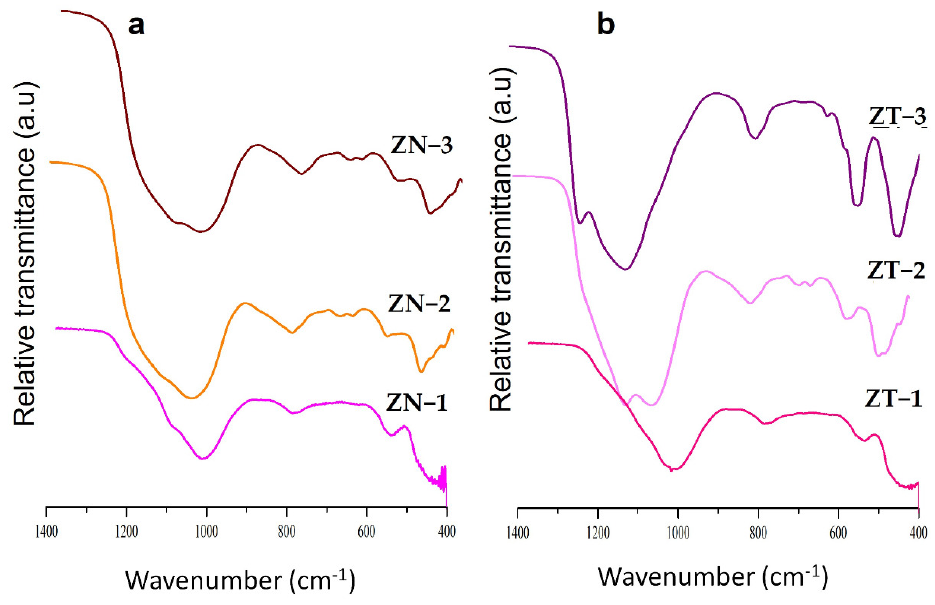
Figure 5. FTIR spectra of ZSM-5 synthesized using NaOH ( a ) and TPAOH ( b ).